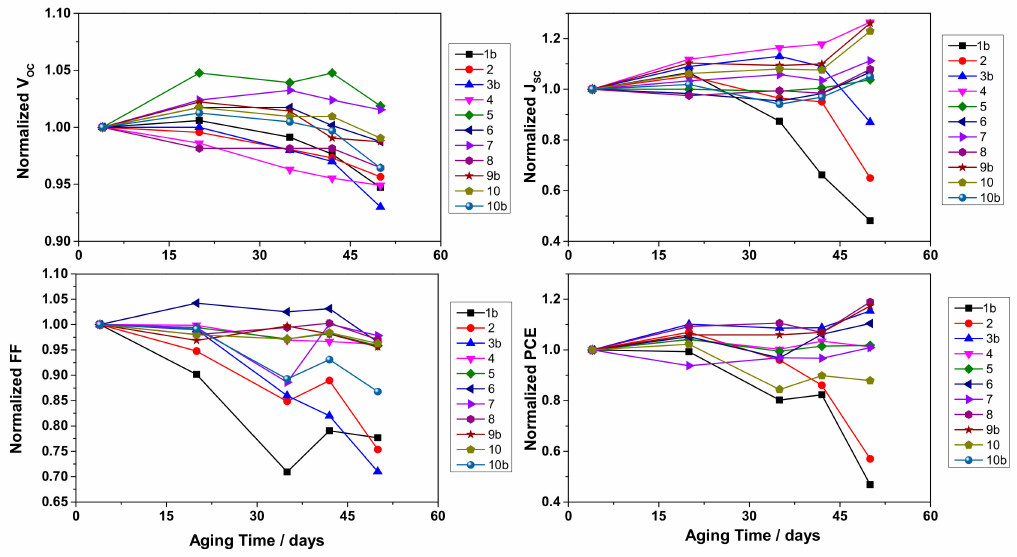
Figure 7. Photovoltaic parameters of DoE cells during the 50 days of the aging test. Data points refer to the third of three consecutive measurements at 1 sun. Lines just connect data points and have no physical